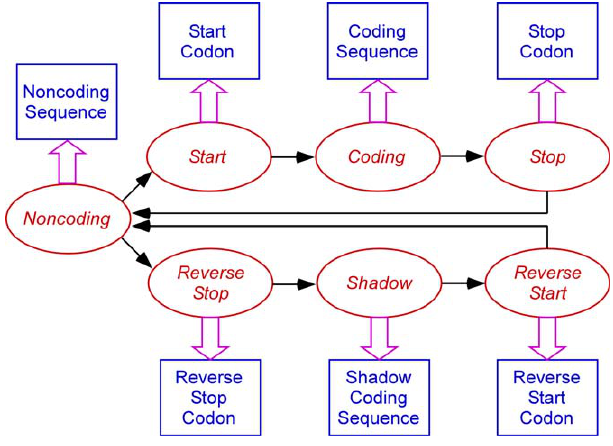
Figure 7. The HMM